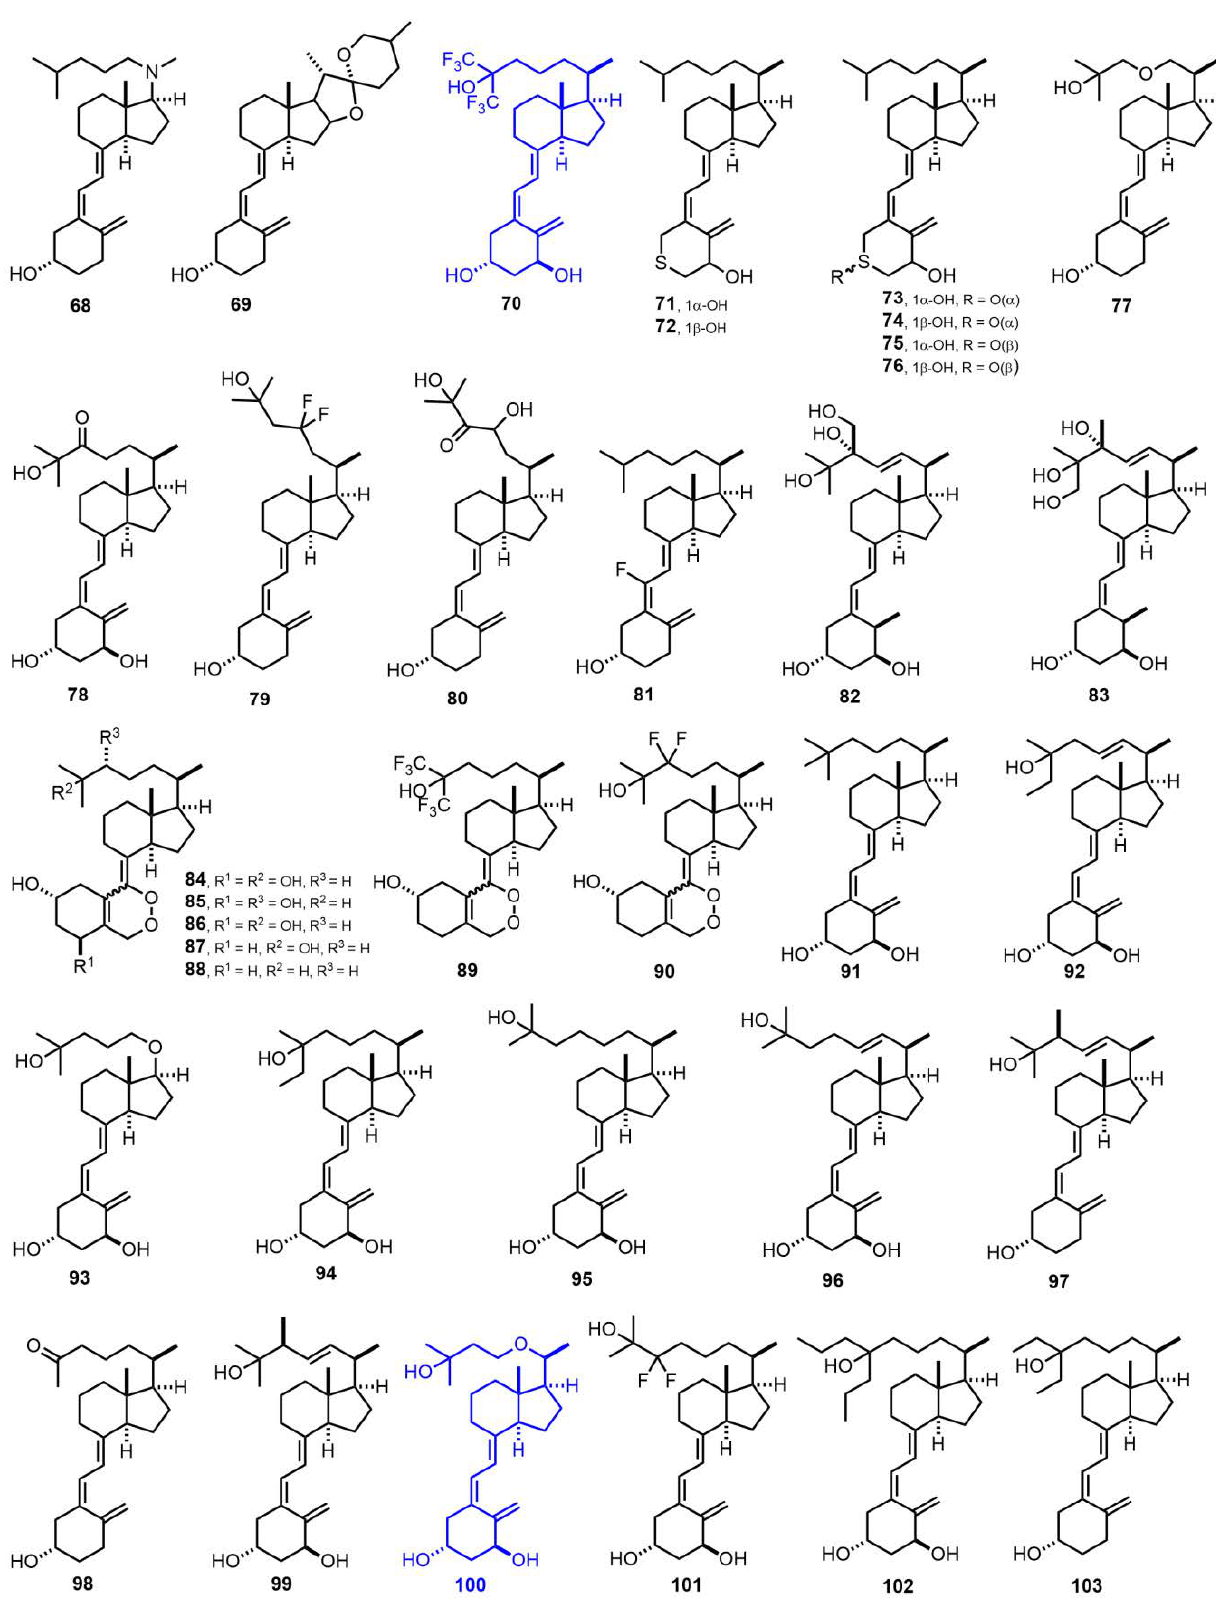
Figure 3. (1982–1987)